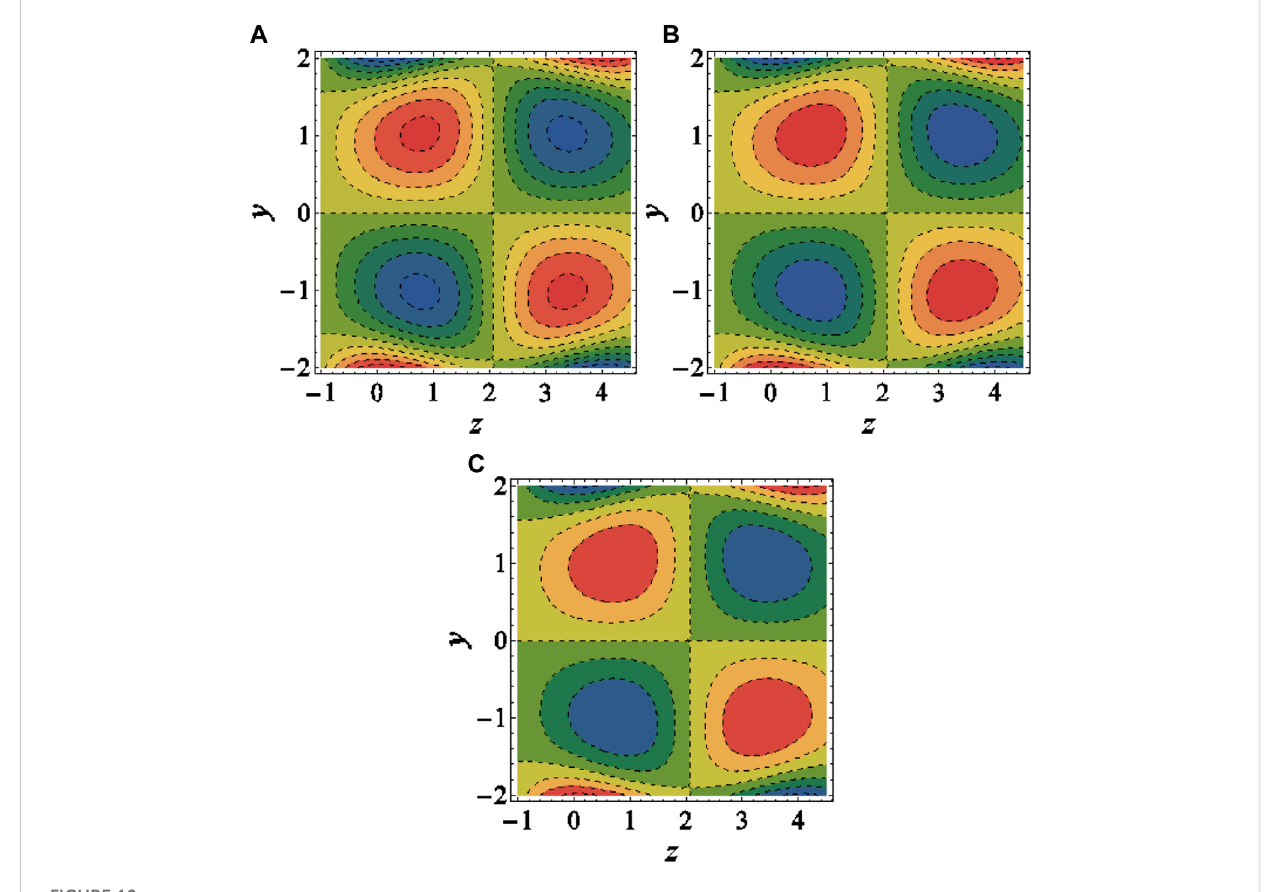
FIGURE 10 (A – C) Flow pattern for α